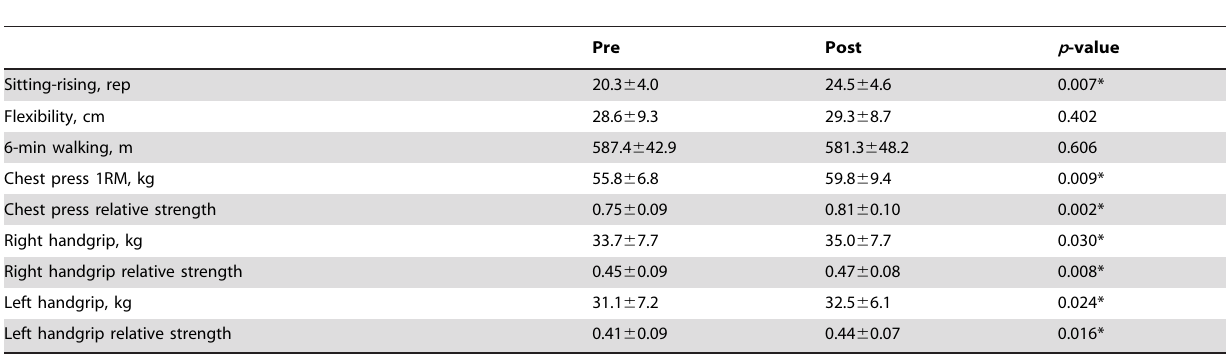
Table 4. Physical fitness tests performed before and after the training program (mean 6